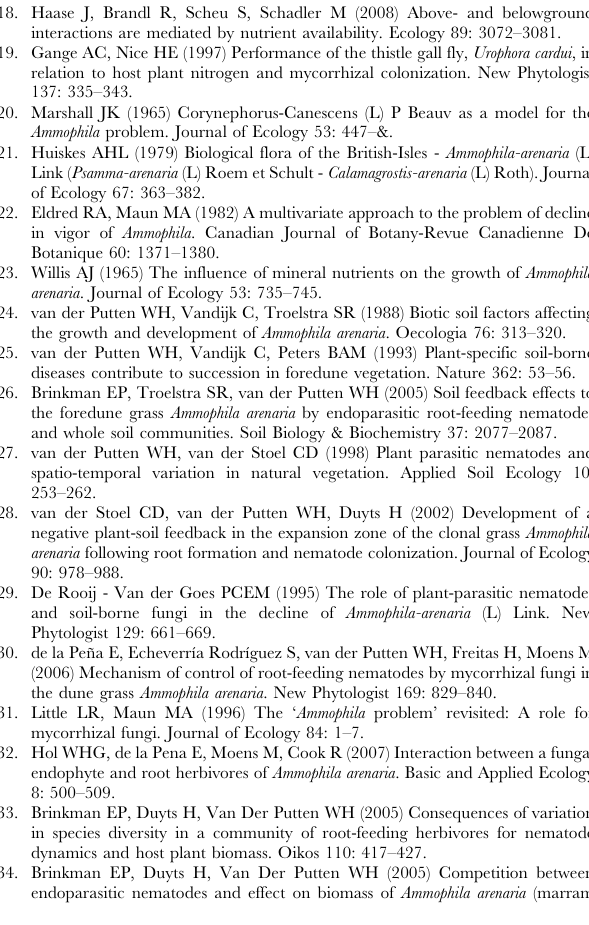
Figure S1 Differences in NO3-N content of treatment soils with different unsterile inocula (mean + SE). Significant pairwise differences are indicated by different letters above the bars (P , 0.05). Inoculum - /: no inoculum, d: dynamic dune biota, s: stabilised dune biota. Figure S2 Differences in soil parameters of treatment soils according to region and abiotic soil component (mean + SE). A) dry matter. Significant pairwise differences are indicated by